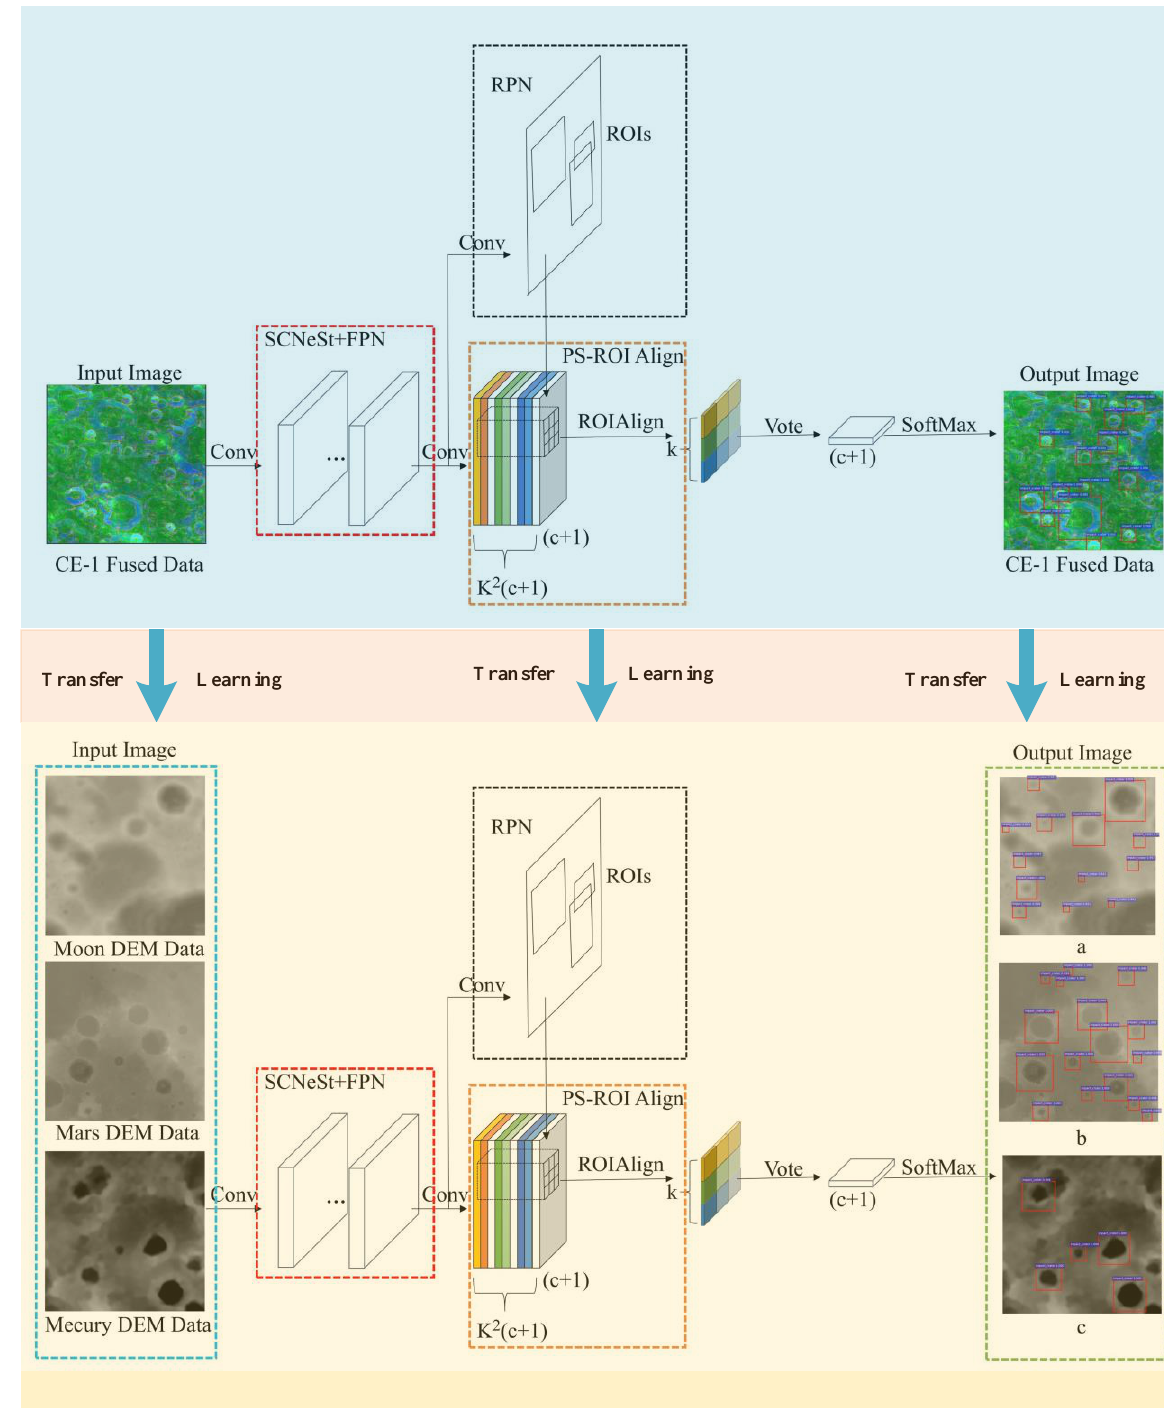
Figure 1. Deep space impact crater detection framework based on the improved R-FCN.